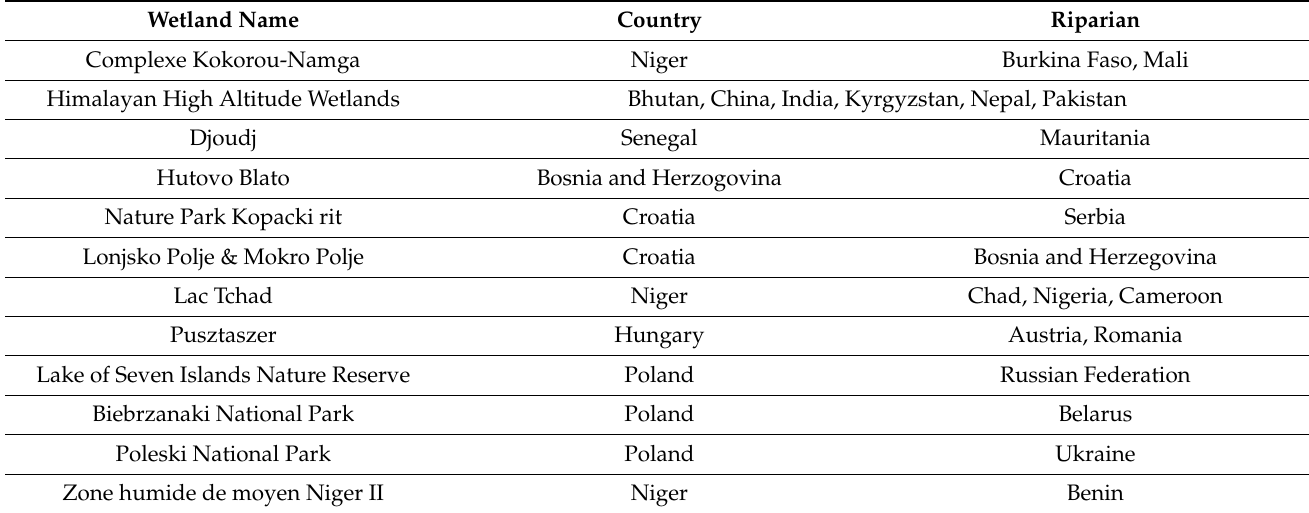
Table 3. Additional transboundary wetlands identified by Griffin and Ali (2012) [40] that were not listed by the Ramsar Sites Information Service as extending across country borders.